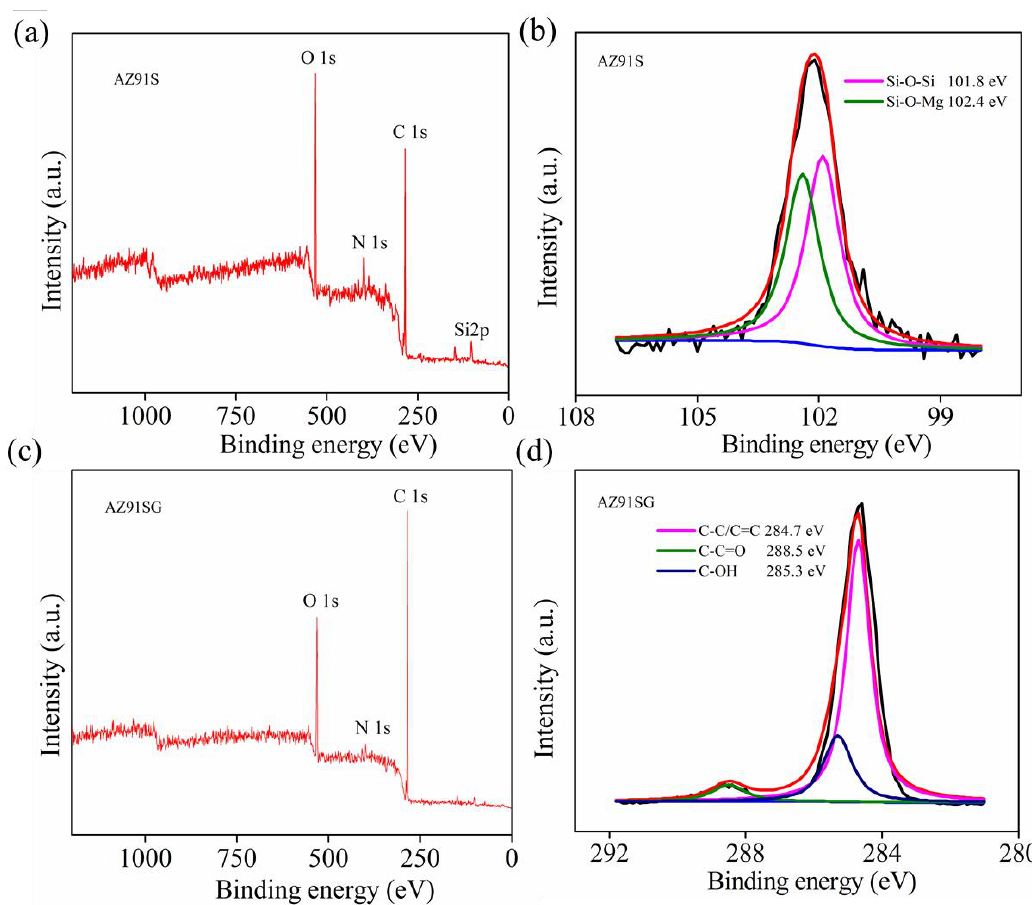
Figure 3. Survey XPS spectra of ( a ) AZ91S with high resolution of ( b ) Si 2p spectrum; Survey XPS spectra of ( c ) AZ91SG with high resolution of ( d ) C 1s spectrum to further study the chemical interaction between silane and GO.